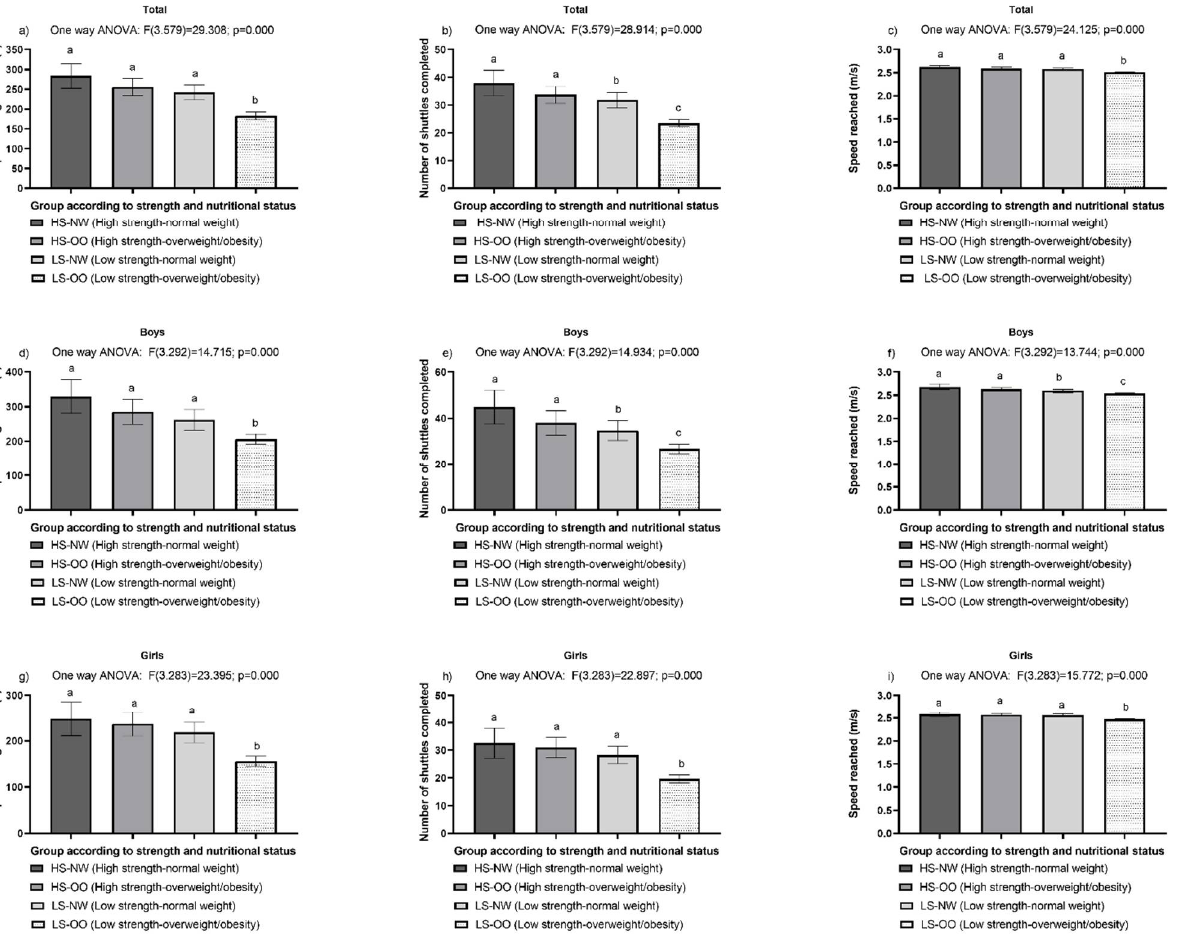
Figure 1. Characteristics of the cardiorespiratory capacity of the total sample, according to sex and group. HS, high strength; LS, low strength; NW, normal weight; OO, overweight/obese. Average a, b, c within a row with a different symbol indicates significant differences between groups (one-way ANOVA and post hoc comparison with Bonferroni test). A p < 0.05 was considered for all analyses.